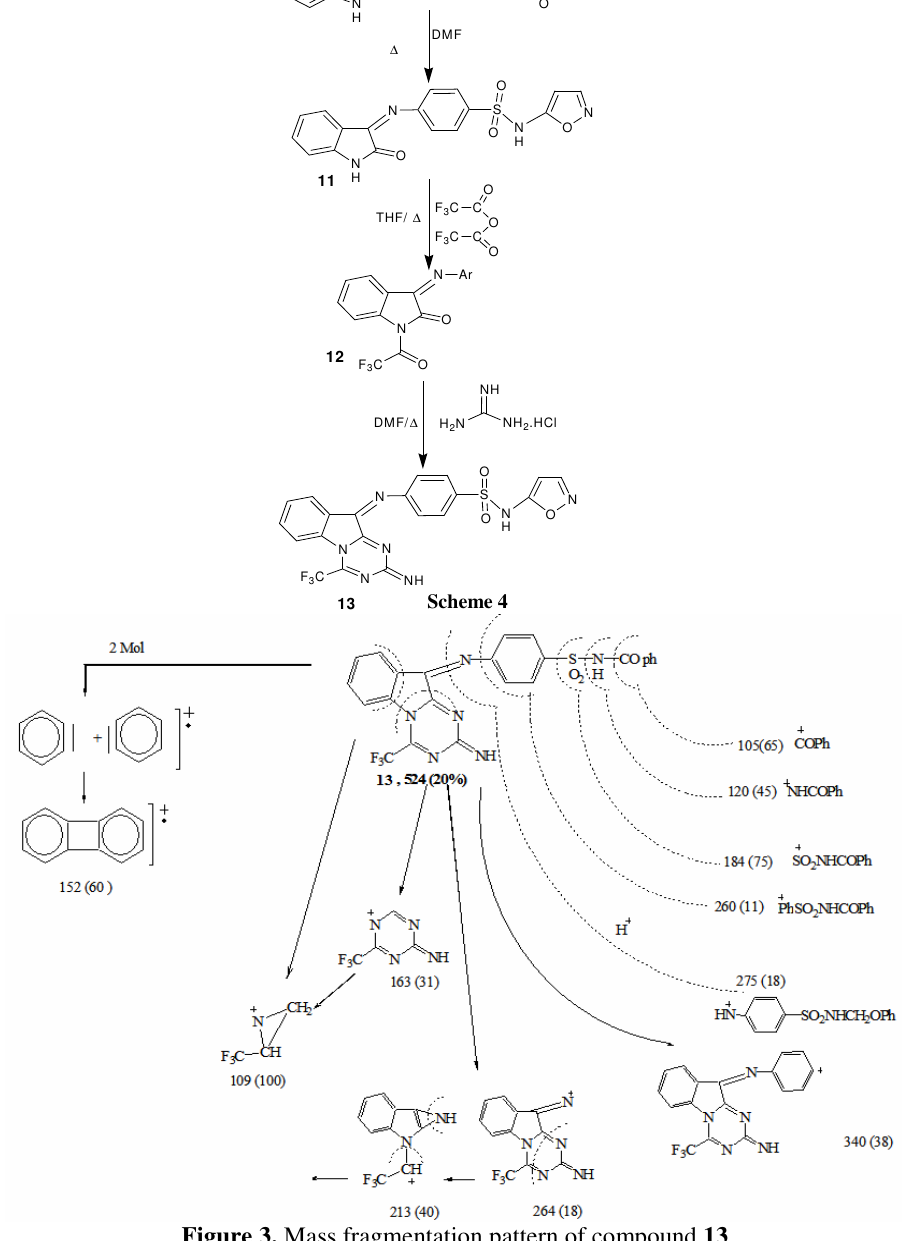
Figure 3. Mass fragmentation pattern of compound